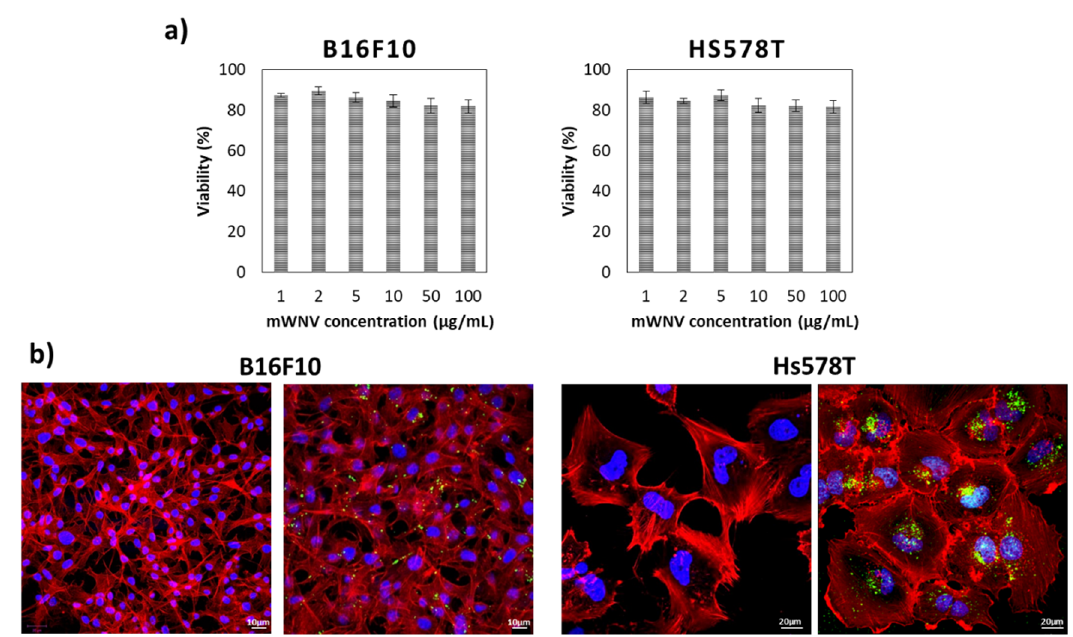
Figure 1. ( a ) Cell viability of B16F10 (left) and Hs578T (right) cells in 2D cultures after 48 h of exposure to a wide range of control unloaded mWNVs concentrations (0.5–100 µg/mL). No statistically significant differences were observed at any of the concentrations tested. ( b ) Confocal microscopy images of B16F10 (left) and Hs578T cells (right) alone (left) and exposed (right) to control unloaded mWNVs (green) for 24 h. Actin (red channel) and nucleus (blue) were stained with TRITC-phalloidin and DAPI, respectively. The mWNVs appear as green dots from emission of the fluorescence dye DiO.